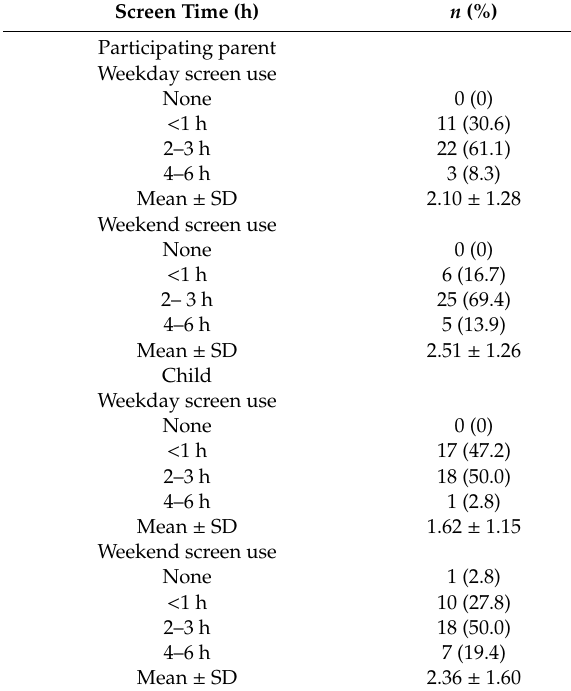
Table 2. Description of parental and child screen use ( n =